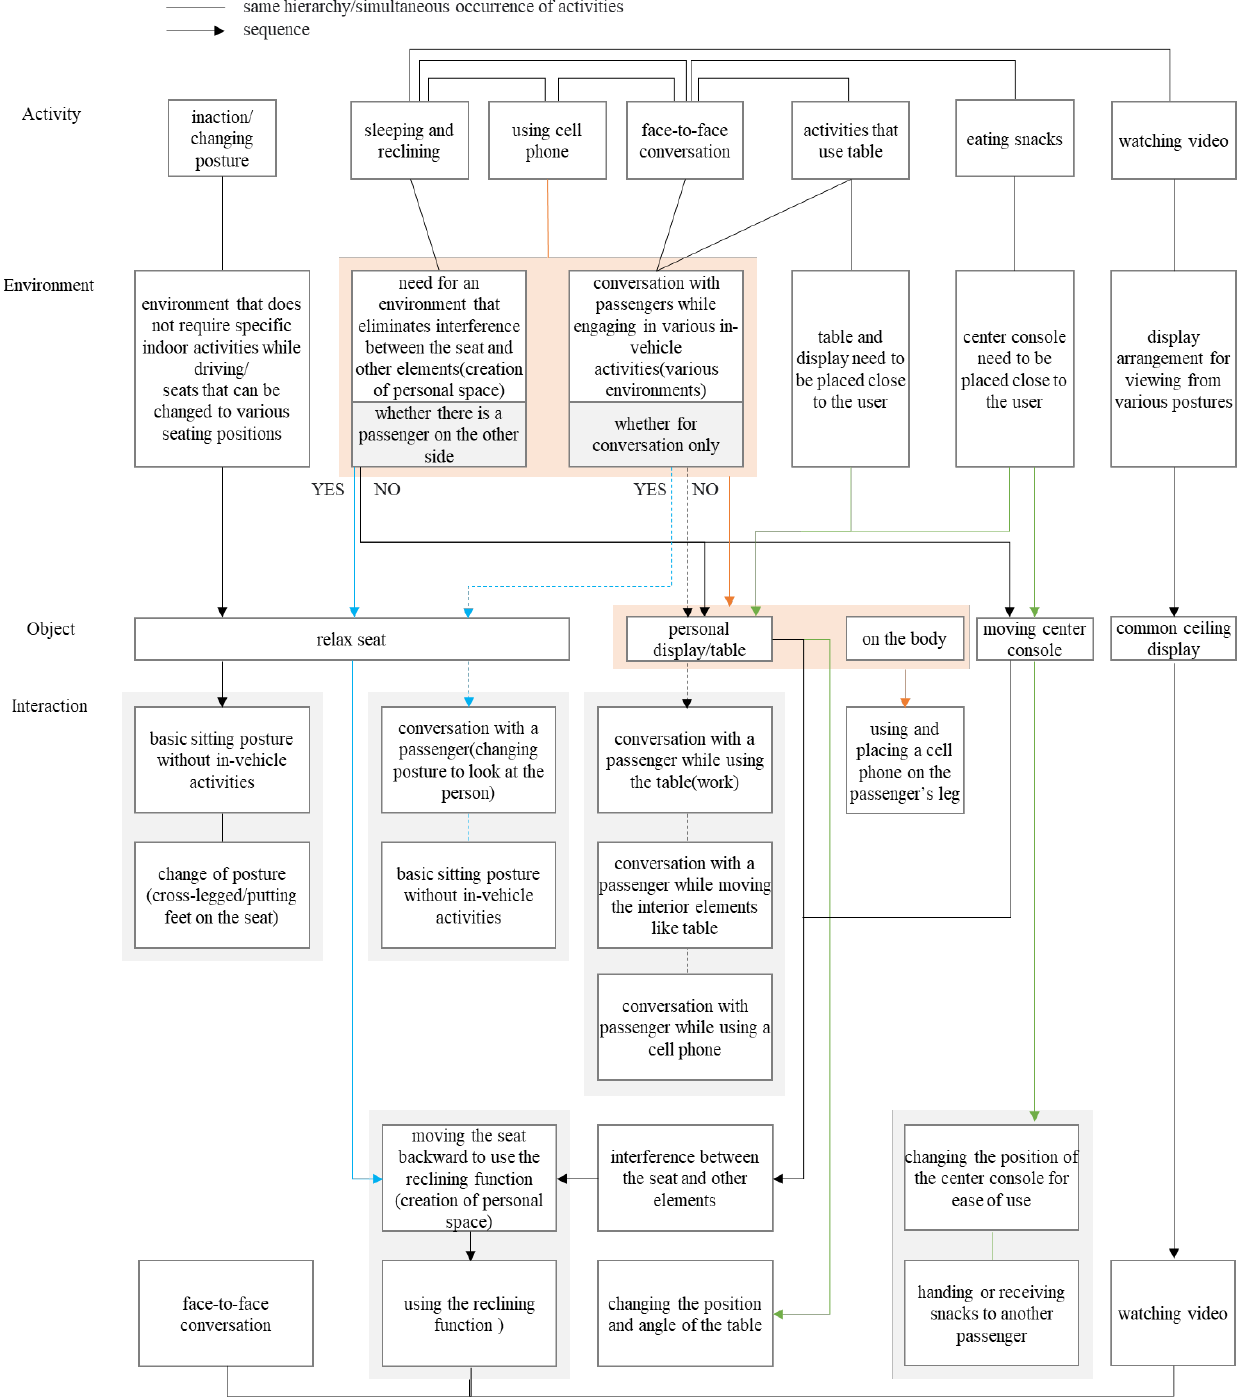
Figure 4. Indoor environment relationship and design elements through analysis of action.